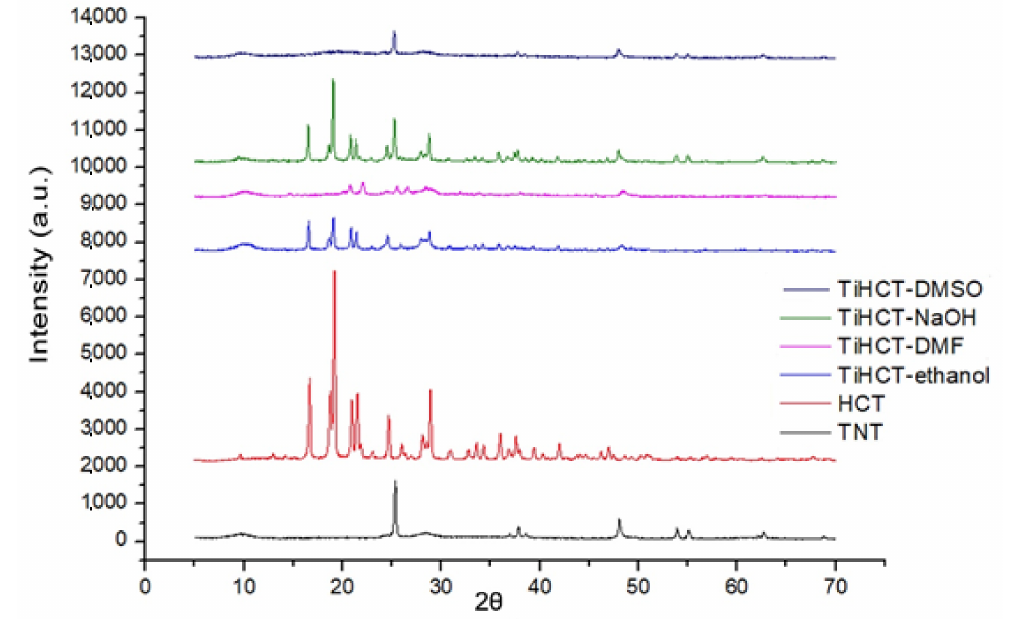
Figure 9. X-ray di ff ractograms of HCT and its